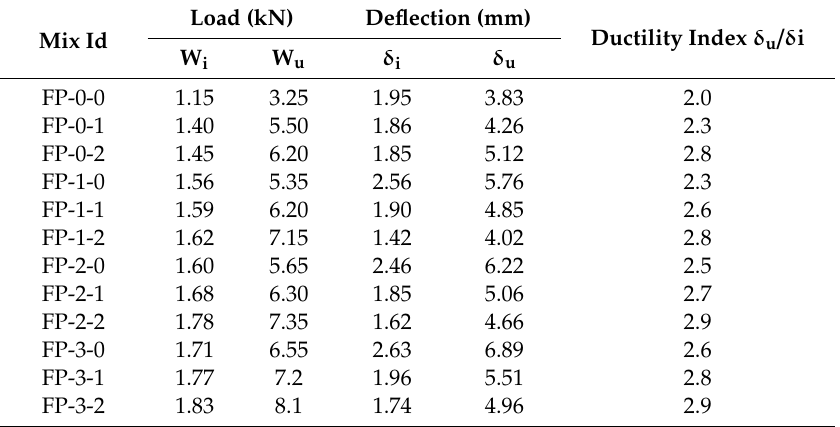
Table 2. Load and deflection comparison of ferrocement panel for flexural